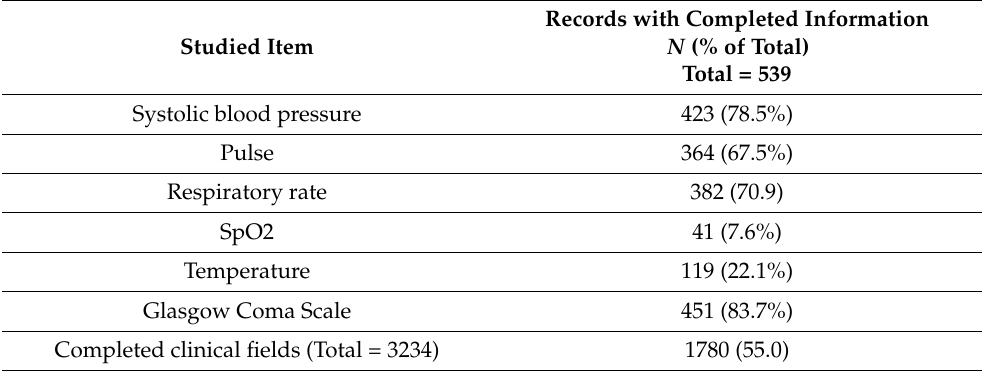
Table 3. Availability of clinical data in the medical records of trauma